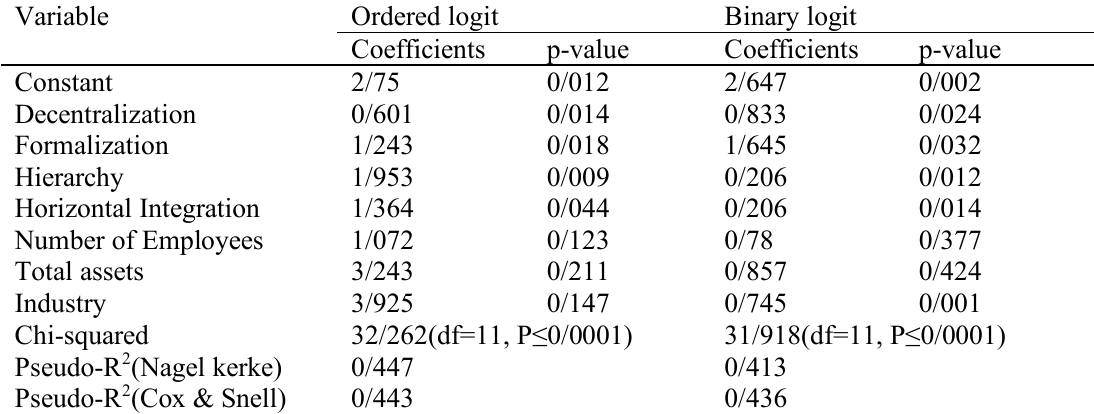
Table 10 . The stage of PMS development tests in four structure